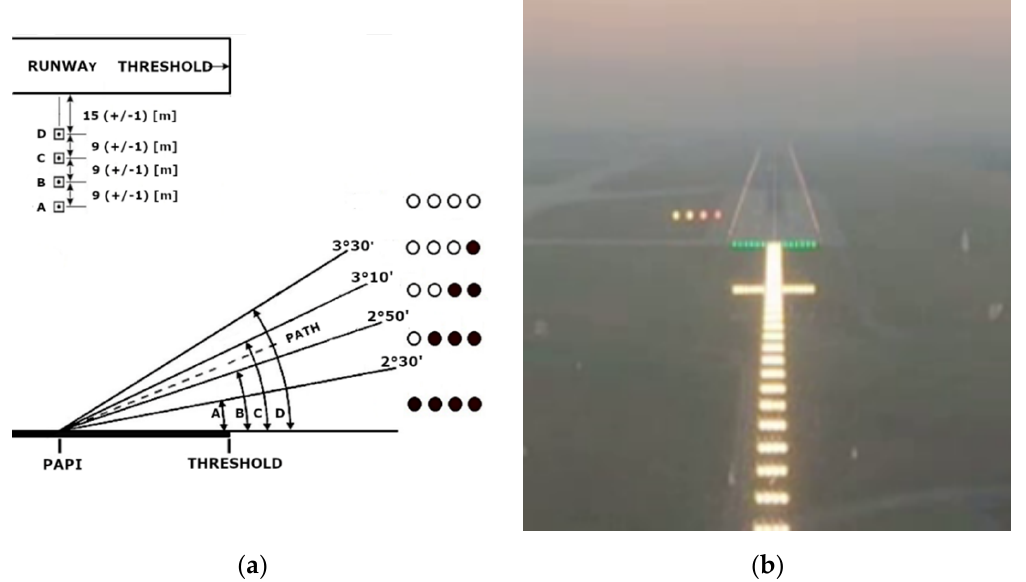
Figure 1. PAPI light system: ( a ) the typical configuration of the PAPI lights; ( b ) a sample image of pilot’s view.